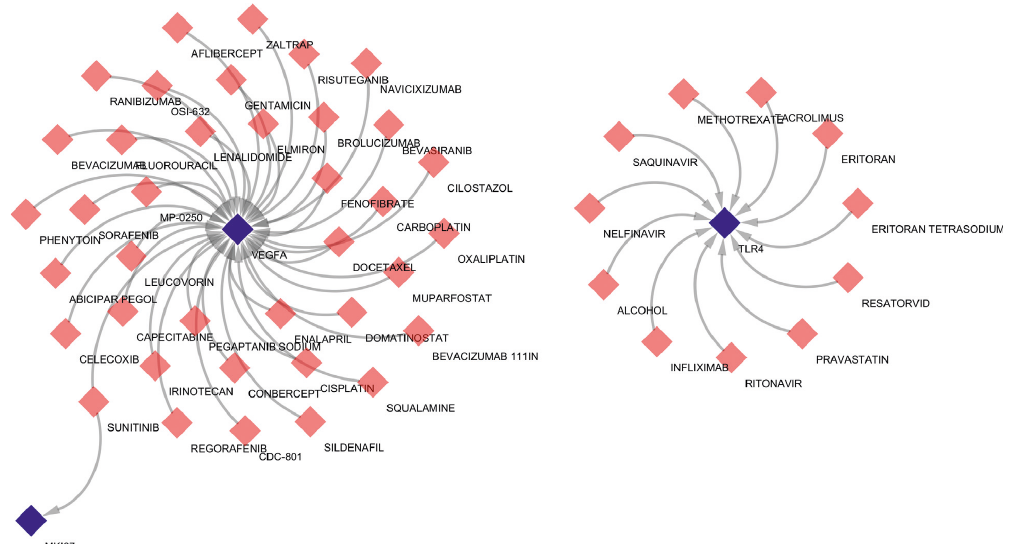
Figure 9: The drug-gene interaction network. The blue diamond nodes are the genes, and the red diamond nodes are the